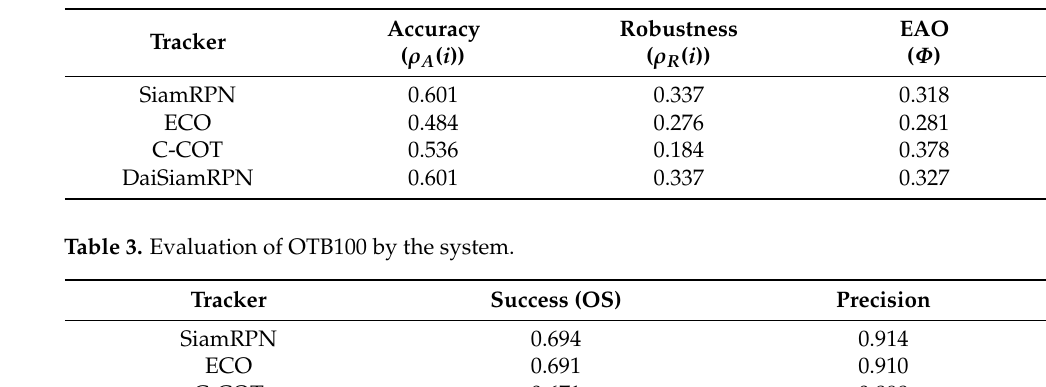
Table 2. Evaluation of VOT2018 by the system.